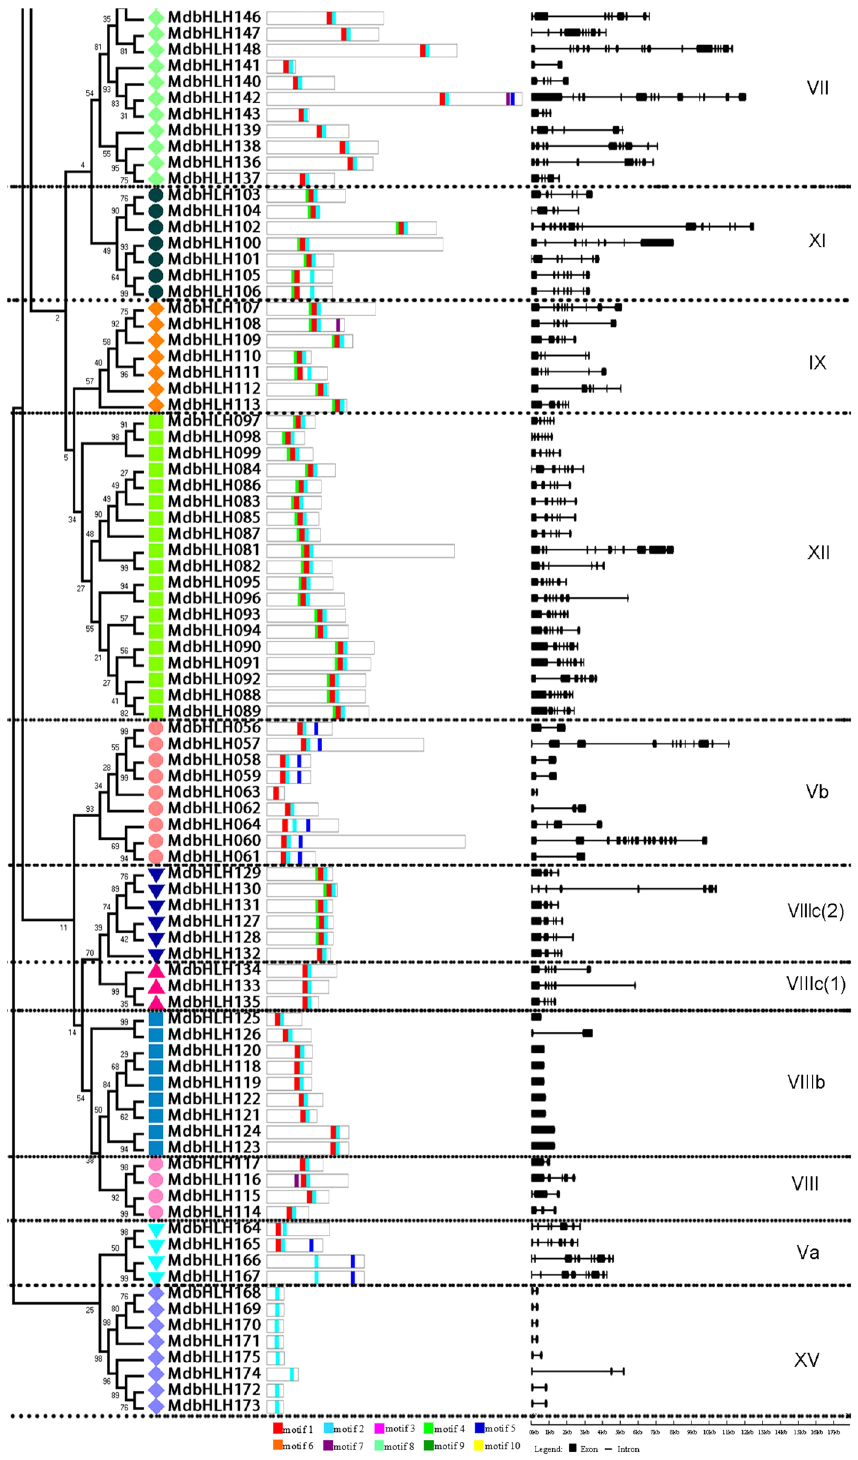
Figure 3. The structure of apple ( Malus × domestica ) bHLH transcription factors. ( a ) The phylogenetic trees were constructed using aligned domains of the MdbHLH transcription factors with MEGA 5.0 software. Reliability of the predicted tree was tested using bootstrapping with 1000 replicates. Numbers at the nodes indicate how often the group to the right appeared among bootstrap replicates. Subtrees branch lines are colored indicating different bHLH subgroups. ( b ) MEME analysis of MdbHLH protein motifs. The motifs, numbered 1–10, are depicted as different colored boxes. The sequence information for each motif is provided in Supplementary Table S4. Motifs 1 and 2 correspond to the bHLH domain. ( c ) Exon/intron structures of MdbHLH transcription factors. Exons are represented by black boxes, whereas black lines connecting two exons represent an intron. Both exons and introns were drawn to